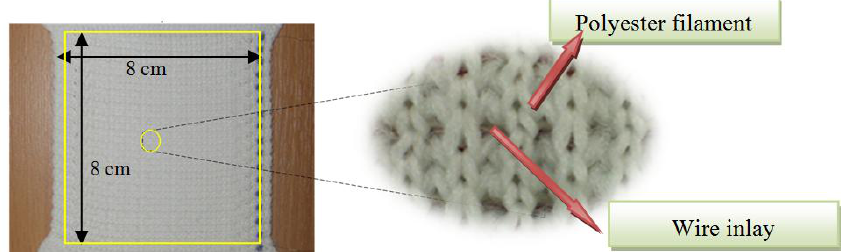
Figure 2. A TSF sample of sensing area of 8 cm × 8 cm along with its magnified